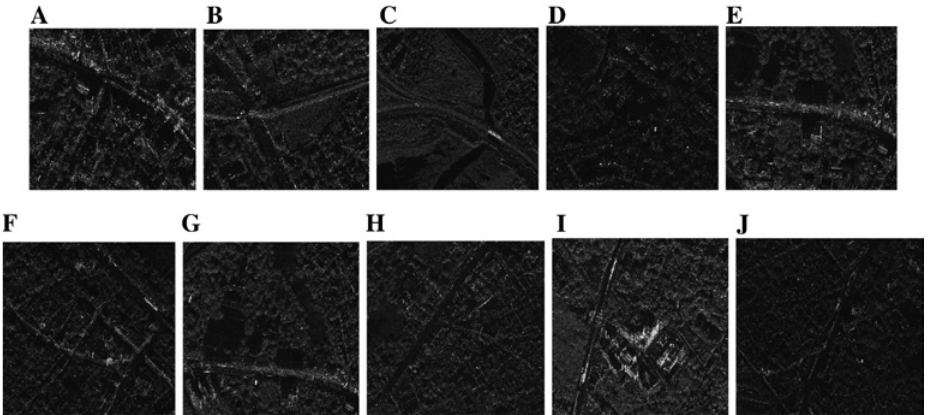
Figure 5: Images Obtained after Convolving with the Fractional Mask of Order k (0.1–0.8) with the Test Image.